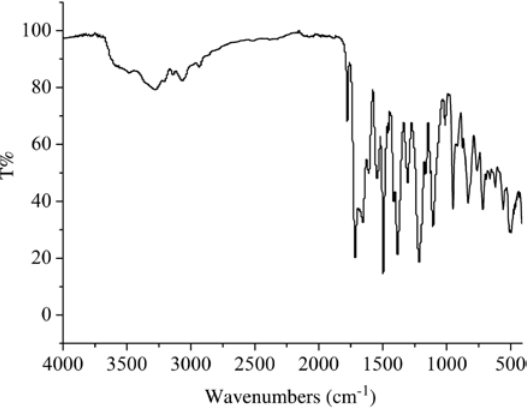
Figure 4: FT-IR spectrum of